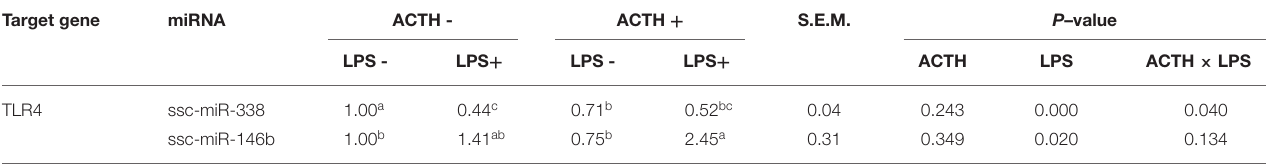
TABLE 3 | Effects of LPS/ACTH on miRNA expressions targeting TLR4 gene in porcine adrenal tissue. Target